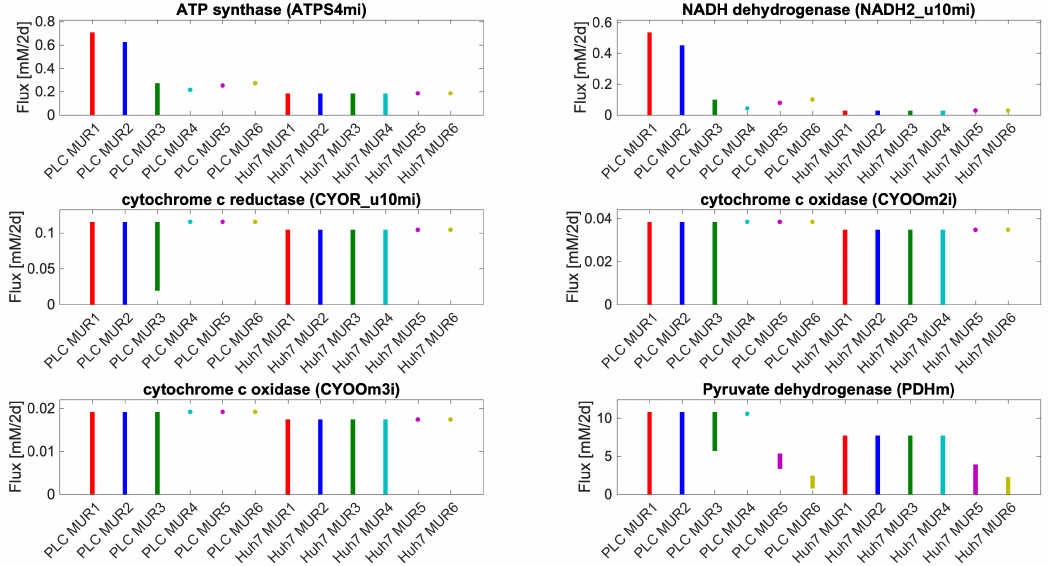
Figure 5. Range of allowed flux values through various reactions related to mitochondrial oxidative phosphorylation while maintaining the maximal biomass flux for the medium condition and cell type specified on the abscissa. See Table S3 for the detailed reactions. Uptake and secretion fluxes of metabolites have units of